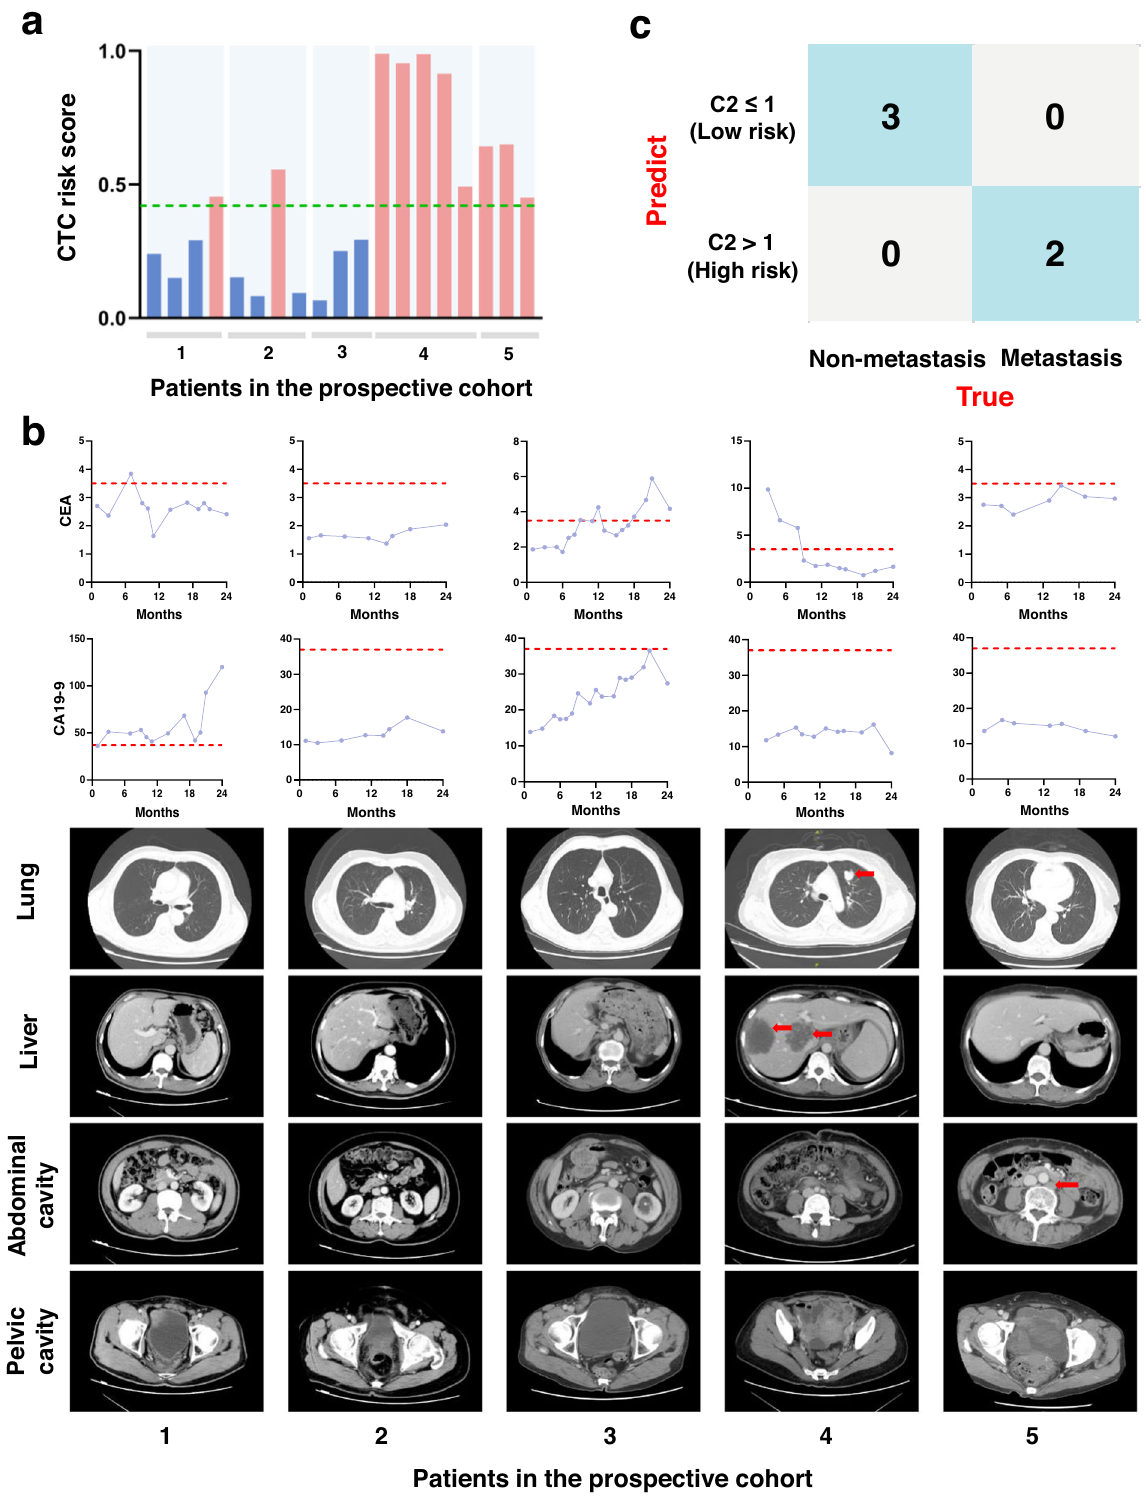
Fig. 6 | Prospective clinical study ofCTC metabolic fi ngerprints. a Risk score of single CTCs in the prospective cohort using the 4-metabolite classi fi er.